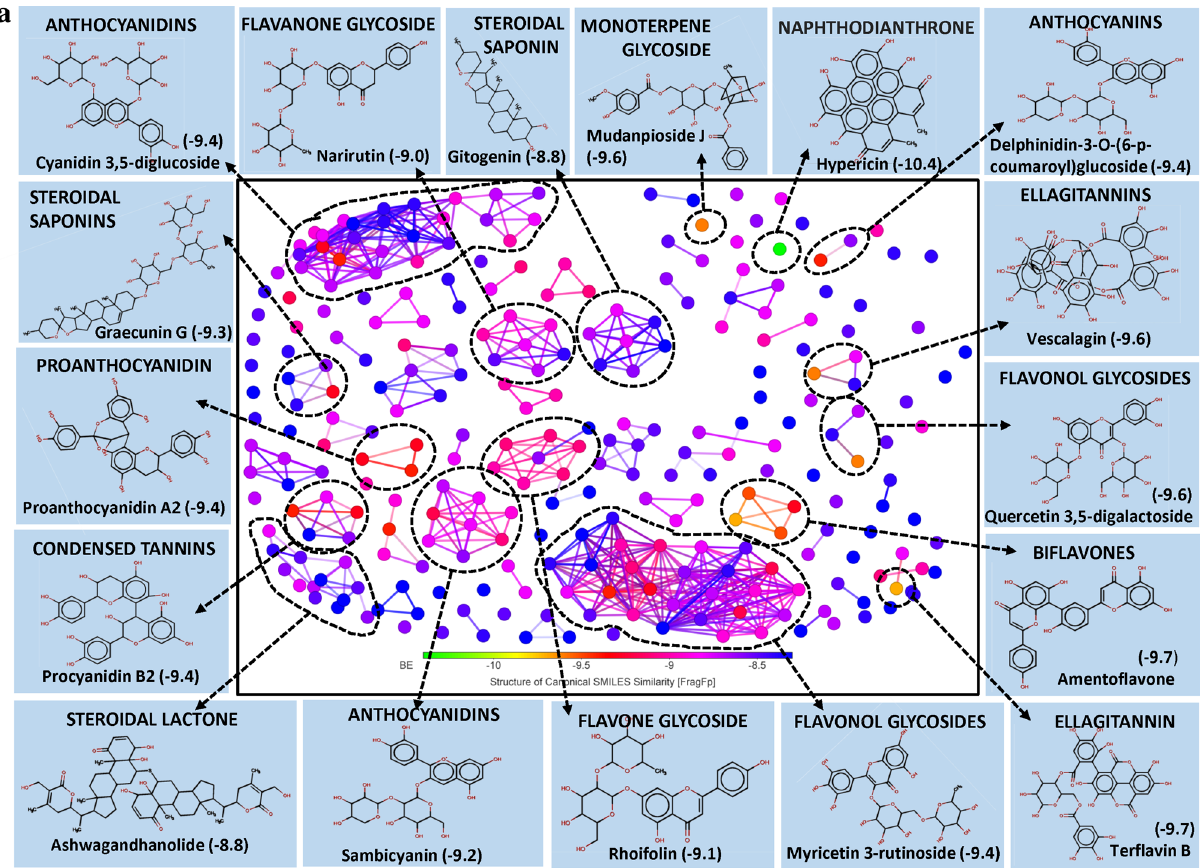
Figure 3. ( a ) Structural activity relationship: Correlation of canonical SMILES structure similarity (data points are joined by colored lines) and binding energy (represented in different color shades of data point) of selected plant secondary metabolites (PSM) evaluated against SARS-CoV-2 M pro using Data Warrior software. Structurally similar molecules are grouped in dotted lines and a representative molecule with low binding energy (kcal/mol) (values in parenthesis) is represented in box. In this case, flavonol glycosides (> 16%) and Anthocyanidine (> 16%) are the largest group of PSM among the top ranked 250 PSM. ( b ) Data analysis of selected PSM against SARS-CoV-2 M pro . ( A ) Bioavailability radar chart representing lipophilicity (LIPO), Molecular weight (SIZE), Topological polar surface area (POLAR), Solubility (INSOLU), Flexibility (FLEX) and Saturation (INSATU) along with Bioavailability score (BAS) of selected molecules, ( B ) 3D visualization of protein–ligand interaction using PyMOL (selected amino acid residue of target site of protein are colored in cyan, and ( C ) 2D visualization of different types of interactions between ligand and target site of protein using Discovery Studio software (different types of interactions are represented in color